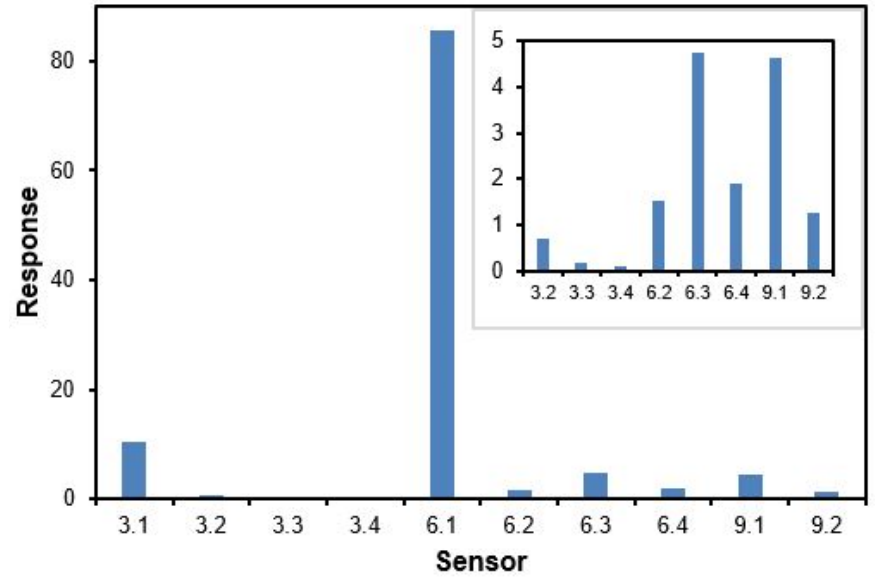
Figure 3. Response patterns for ten sensors functionalized with thiol-ureas (3.1–3.4 of Series 1, 6.1–6.4 of Series II and 9.1–9.2 of Series III) listed in Table 1 for sensing 1 ppm acetone in synthetic air. The inserted graph is a magnified view of all responses below 6.